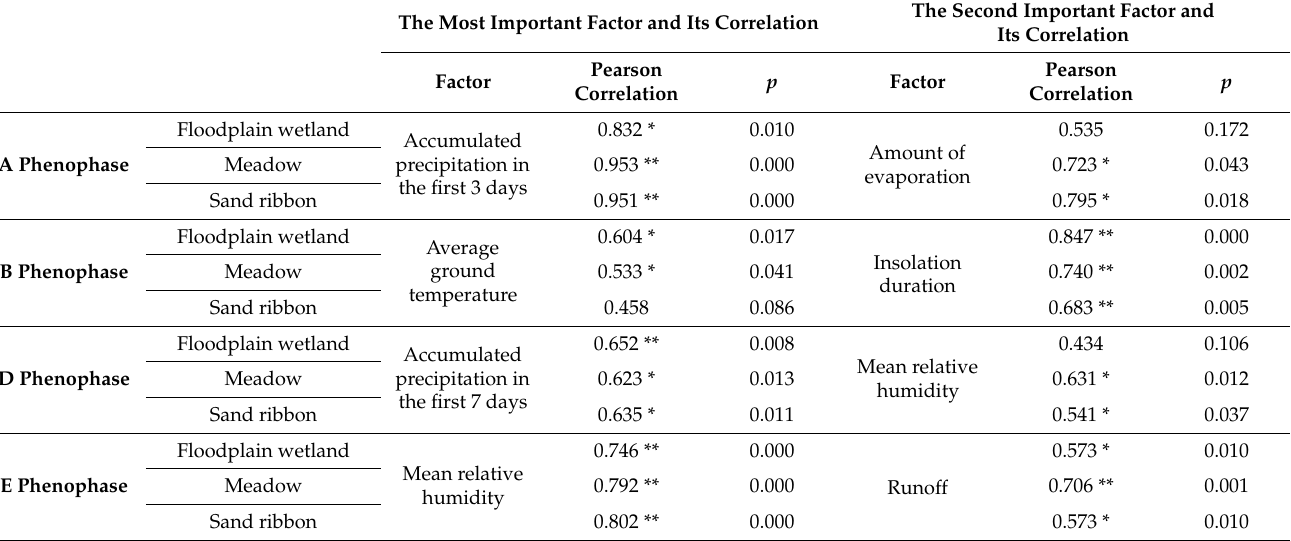
Table 4. Correlation analysis of different phenological